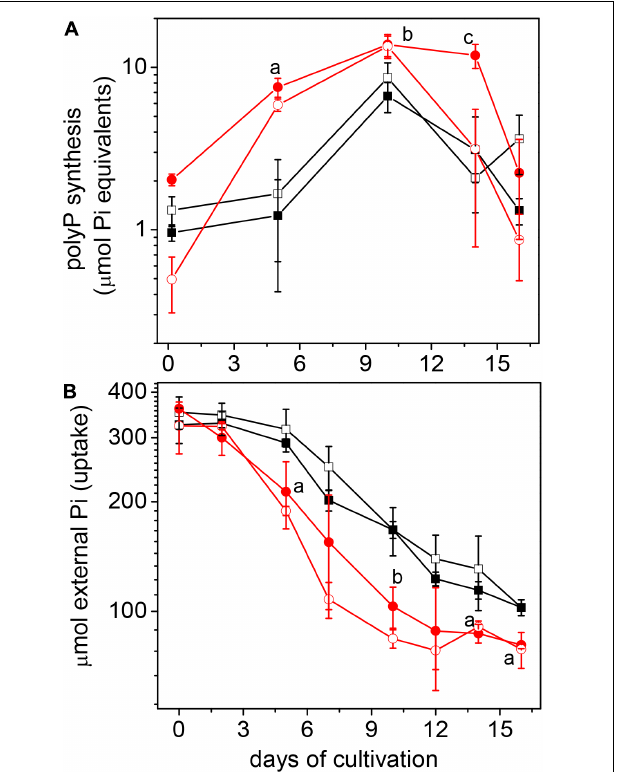
FIGURE 2 | Phosphate metabolism in Methanosarcina acetivorans cultured in acetate. PolyP synthesis (A) and phosphate uptake (B) were determined in Cnt ( (cid:3) ), Cnt + Cd ( (cid:4) ), CdPA ( • ) and CdPA-Cd ( ◦ ) cells. Values shown are the mean ± SD of 3 independent experiments. PolyP synthesis: a P < 0.01 and b P < 0.05 CdPA vs. Cnt and Cnt + Cd; c P < 0.01 CdPA vs. Cnt, Cnt + Cd and CdPA-Cd. Pi uptake: a P < 0.05; b P < 0.01 CdPA vs. Cnt and Cnt +